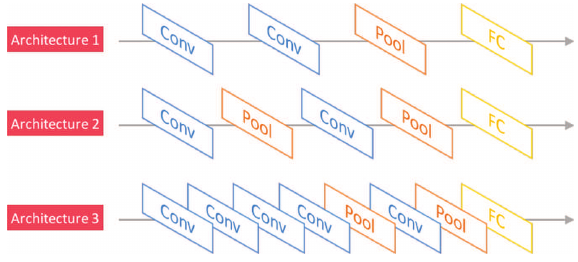
Figure 5: Three Architectures in Workflow 1.